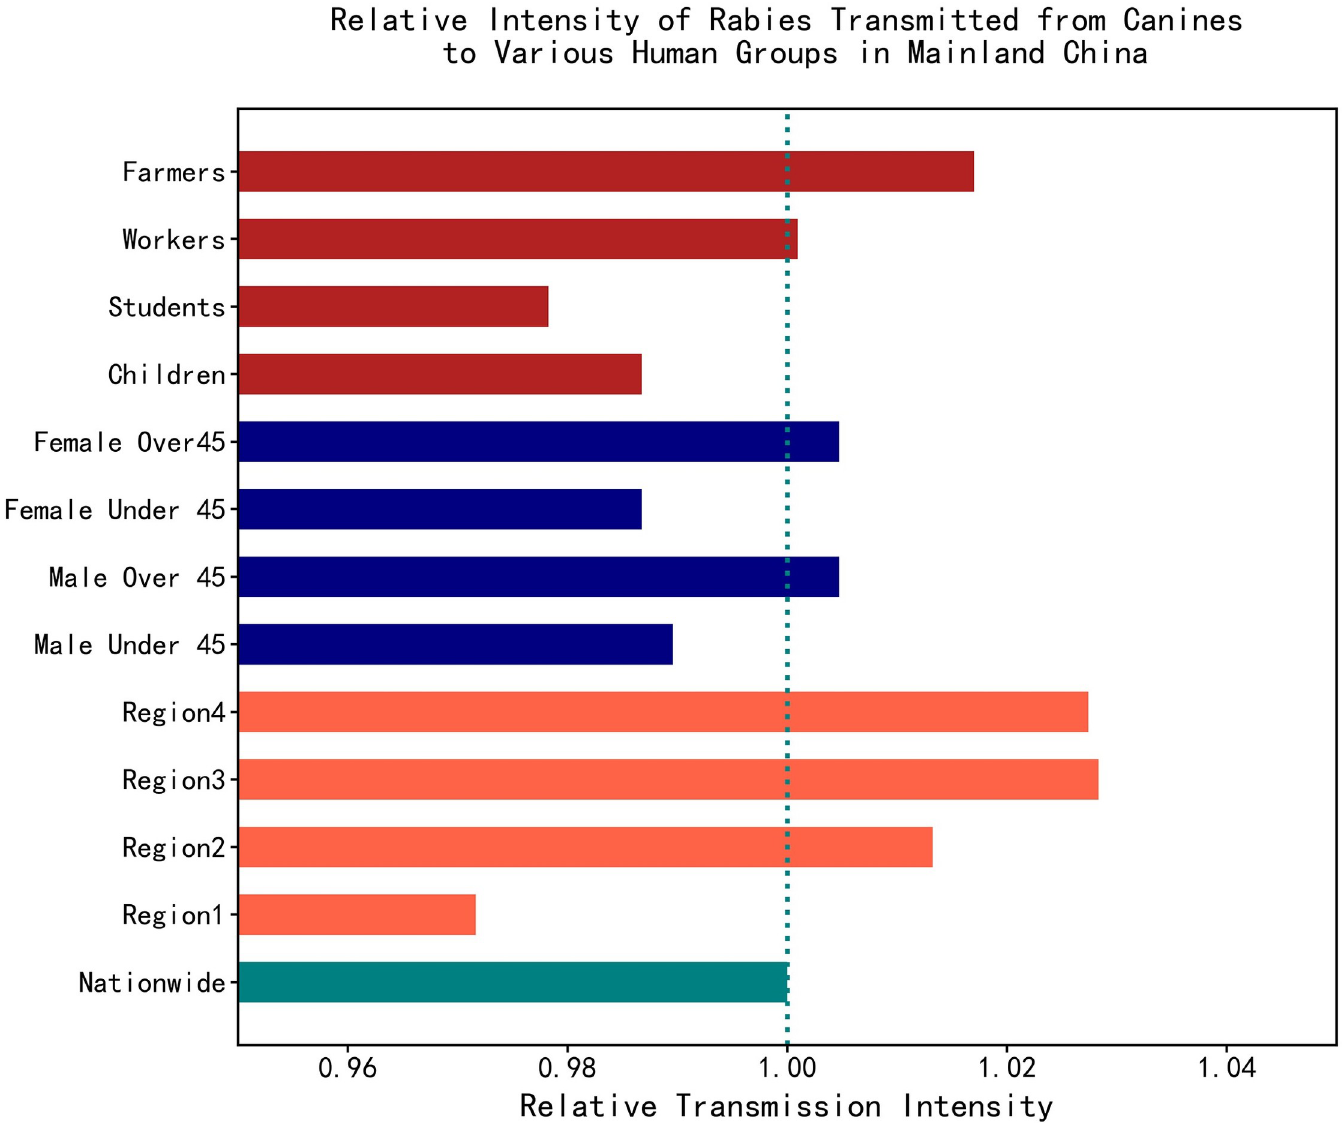
Fig 6. The transmission intensity of rabies from canines to each human population group. The teal color represents the nationwide transmission intensity, whereas the tomato, navy and firebrick color represent transmission intensity of rabies from canines to different regions, age and gender groups and occupational groups,